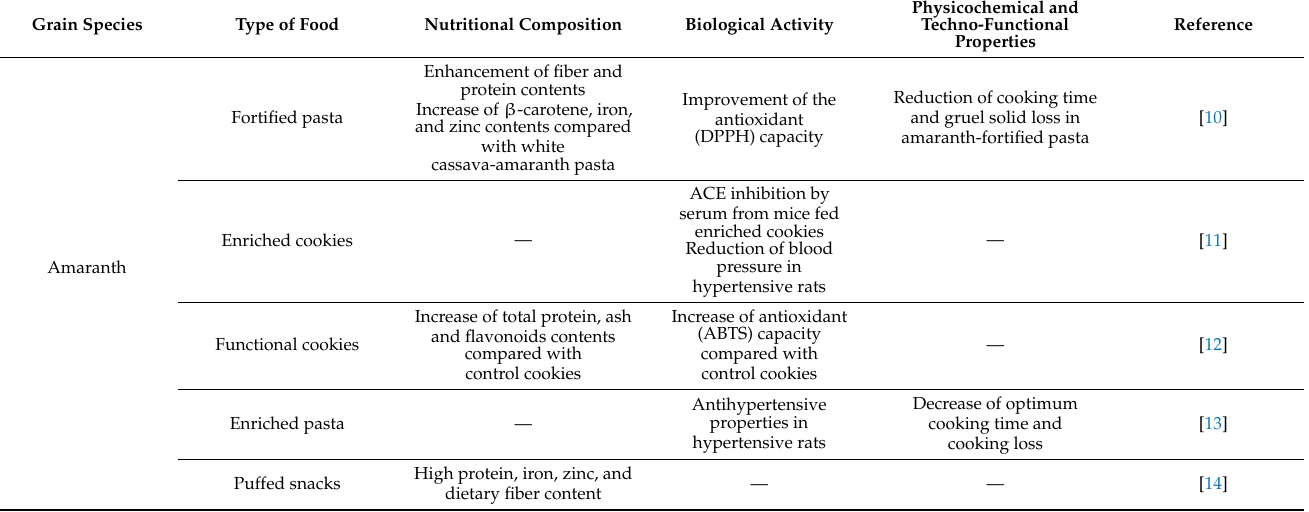
Table 1. Nutritional, biological and techno-functional impact of the incorporation of underutilized grains in functional